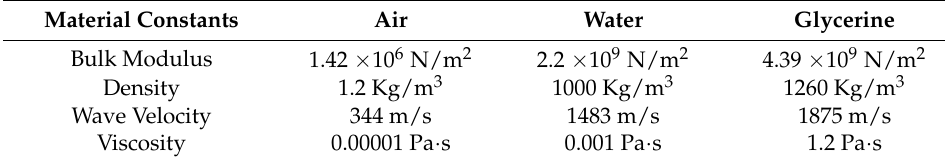
Table 2. Material properties of